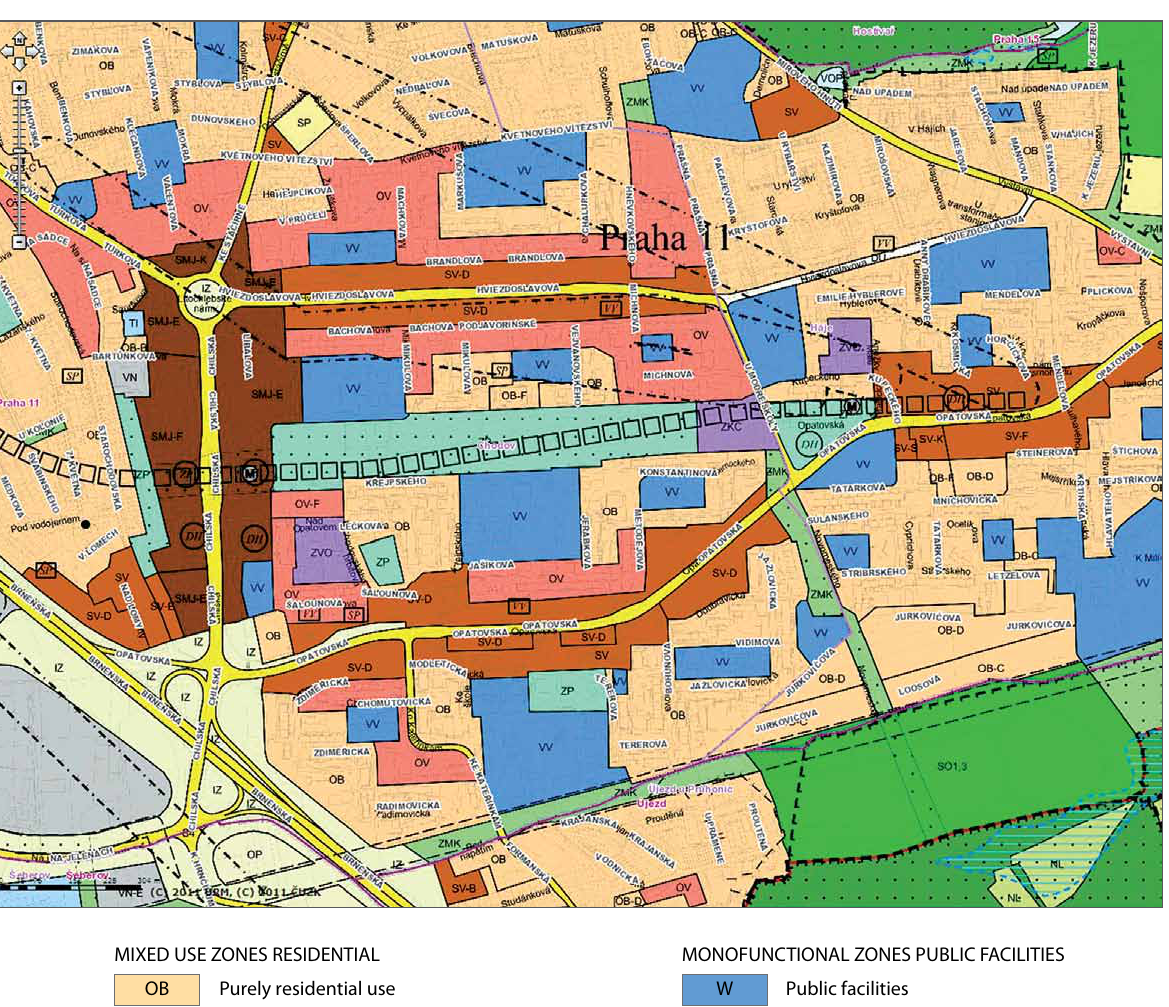
LANDSCAPE AND GREENERY LR